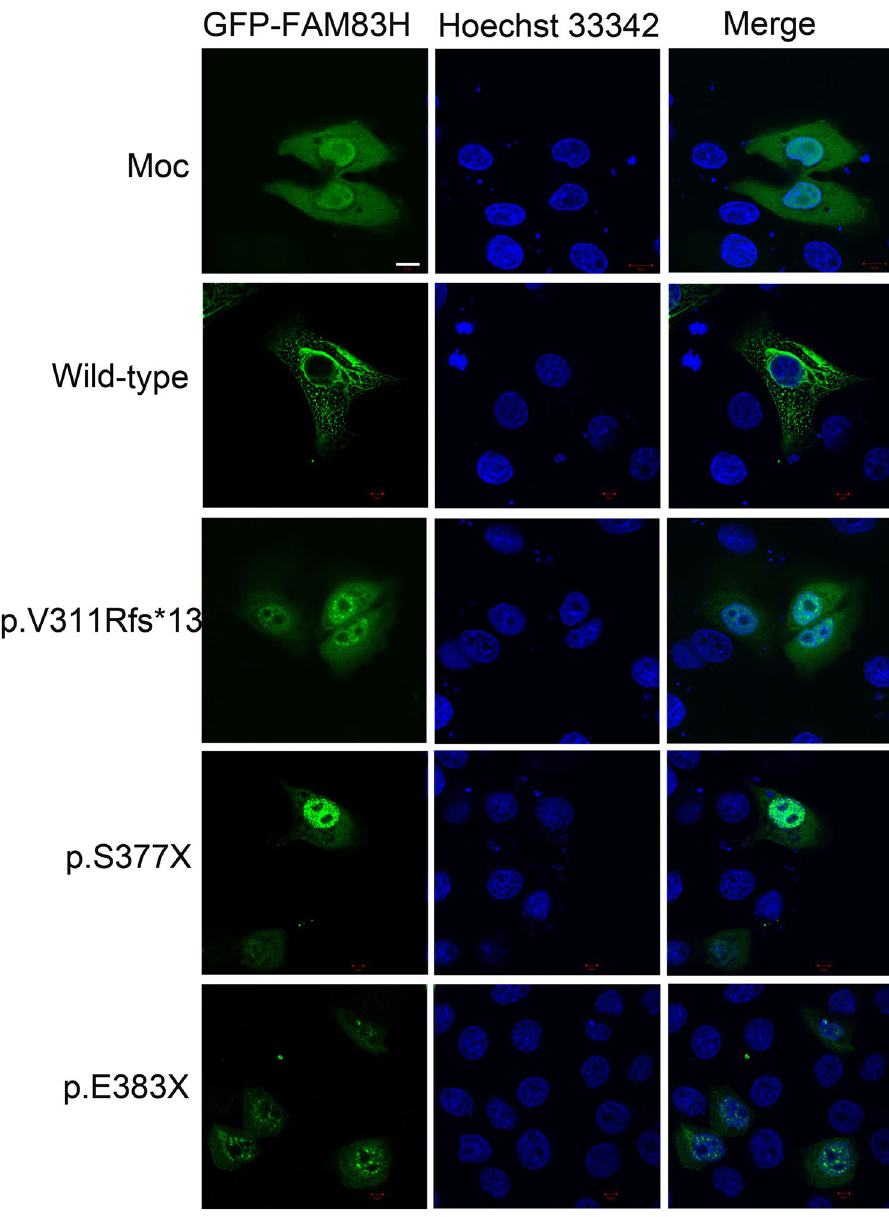
Figure 5. Subcellular localization of wild-type and mutant FAM83H-GFP in SF2 cells. Wild-type FAM83H- GFP was localized exclusively in the cytoplasm, especially the area surrounding the nucleus. The expression patterns around the nucleus and in the cytoplasm were present as filamentous and speckle-like shapes. The mutant FAM83H-GFPs (p.V311Rfs * 13, p.S377X, p.E383X) were accumulated predominantly in the nucleus with lower levels in the cytoplasm, and their expression pattern was changed into speckle-like shapes. Nuclei were stained with Hoechst